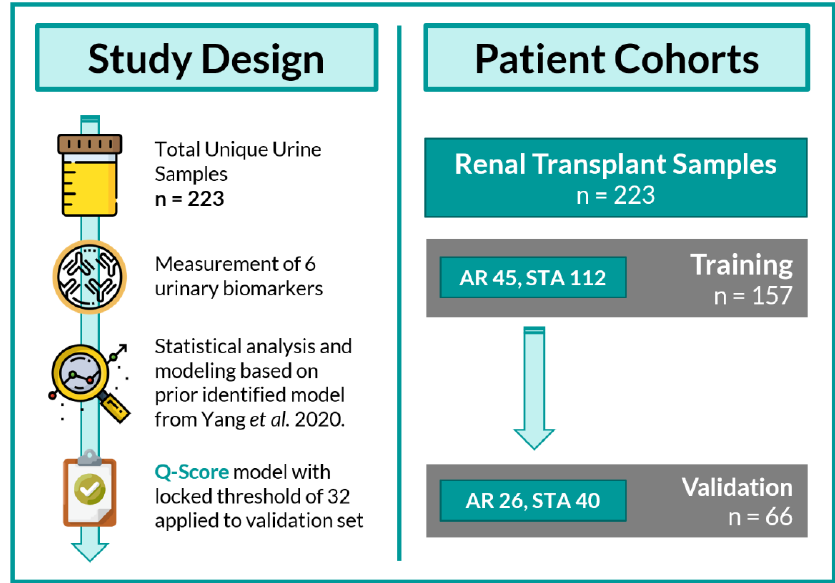
Figure 1. Study design: This study involved a total of 223 urine samples. Each urine sample was paired with renal transplant biopsy for phenotype classification into either of the following diagnoses: stable/healthy (STA: n = 152) and acute rejection (AR: n = 71). The urinary biomarkers were measured on all the urine samples collected, and statistical analyses were performed on stable and acute rejection transplant patients. Samples were randomly split into training ( n = 157) and validation sets ( n = 66). The Q-Score model was developed using training data and then applied to the validation set. The study was designed to demonstrate that the Q-Score algorithm can (a) differentiate AR from STA better than the standard of care test serum creatinine (SCr), (b) detect different rejection phonotypes (TCMR and ABMR), (c) detect AR in both adult and pediatric transplant patients, (d) detect AR regardless the time elapsed since transplantation, and (e) detect subclinical AR. This study cohort is comprised of 194 distinct adult and 29 pediatric kidney transplant recipient urine samples with matched biopsy as a reference standard where the urine was collected immediately before the performance of a biopsy (Figure 2). We assessed the performance of the QSant assays across a wide range of patient characteristics, such as recipient age (age range of 3–76 years), genders (51.6% males and 48.4% females), recipient/donor ethnicities, causes of end-stage renal disease (ESRD), and donor sources (Table 1 ) . Figure 2. The QSant test is designed to quantitatively measure acute kidney transplant rejection using patient urine samples. The test measures six urinary biomarkers: cell-free DNA (cfDNA), methylated cfDNA (m-cfDNA), clusterin, CXCL10, creatinine, and total protein in renal transplant patients. The six-biomarker data are integrated into an algorithm to calculate a composite kidney rejection risk score, Q-Score, from a scale of 0–100 to reflect the probability of allograft rejection risk.